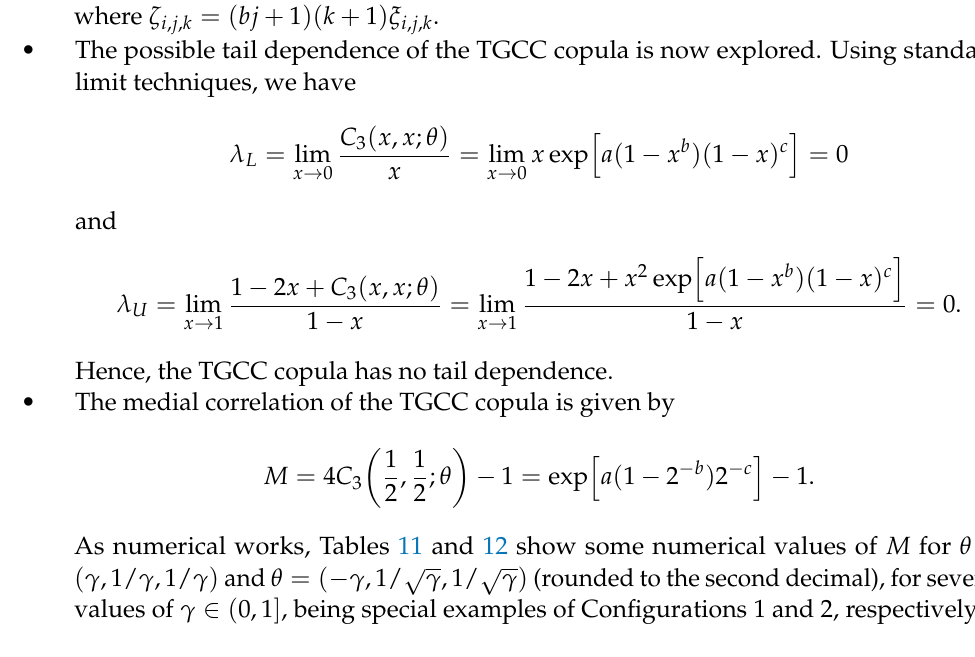
Table 11. Values of the medial correlation of the TGCC copula for θ = ( γ ,1/ γ ,1/ γ ) and several values of γ ∈ ( 0,1 ] , belonging to Configuration 1.